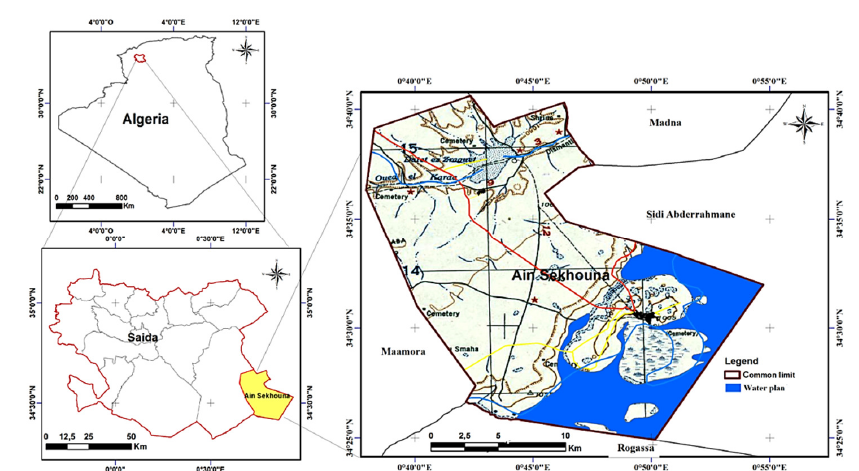
Figure 1. Location of the study area Ain